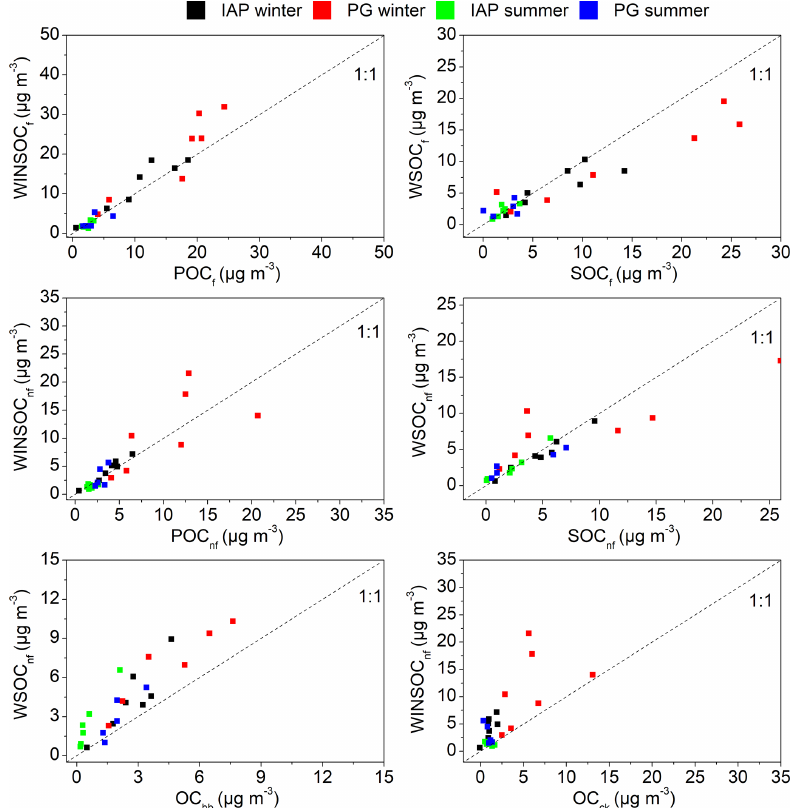
Figure 7. Correlations of WINSOC and WSOC with POC and SOC at IAP and PG sites in winter and summer. The slopes and correlation coefficients are summarized in Table